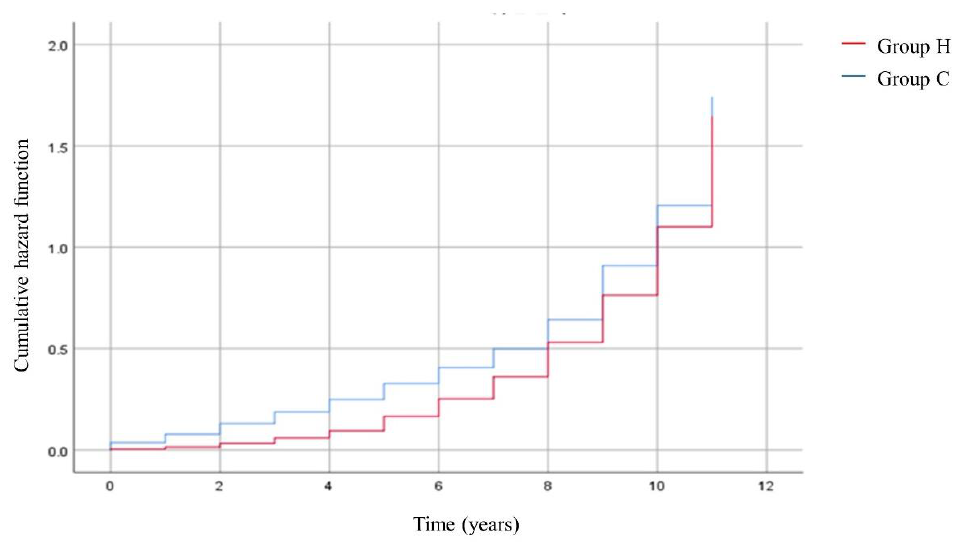
Figure 2. Kaplan-Meier survival curves and Log-Rank tests for development of SSNHL.